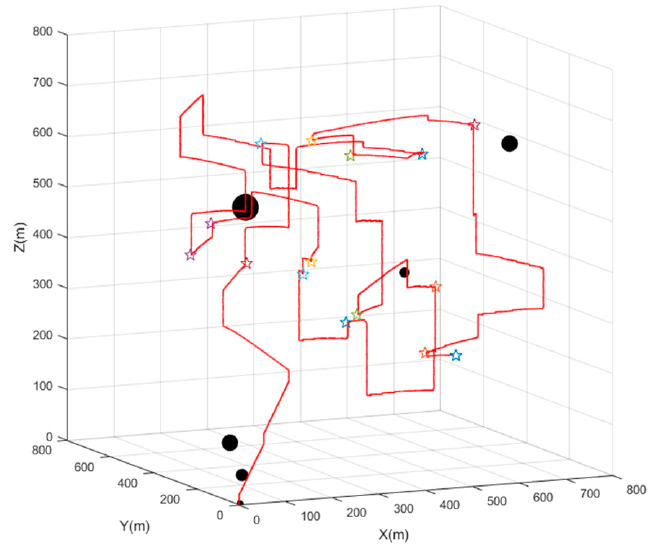
Figure 12. Target search trajectory diagram.